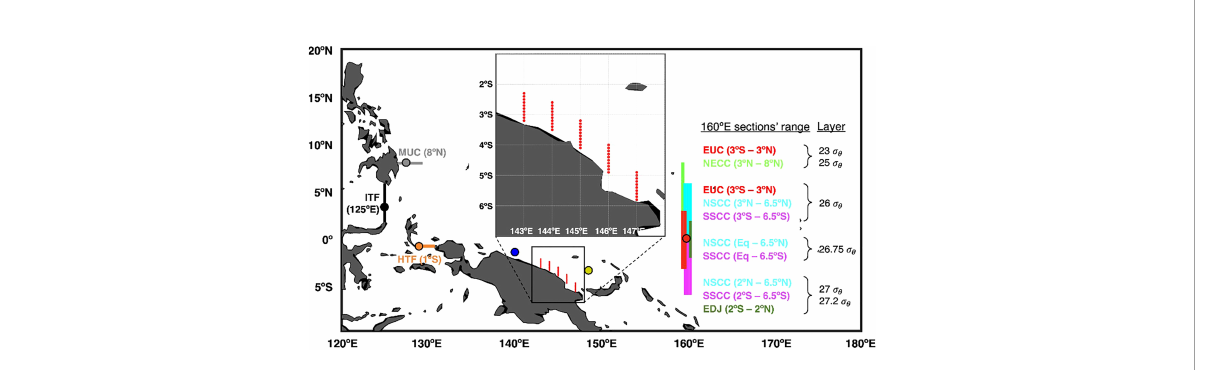
FIGURE 2 Experimental design of LPTM. The 50 red dots along the New Guinea coast are the locations where tracers were released. The color lines denote the location of the sections used to classify the tracers ’ major destinations. Color circles denote the locations that are selected to estimate q -S diagrams.